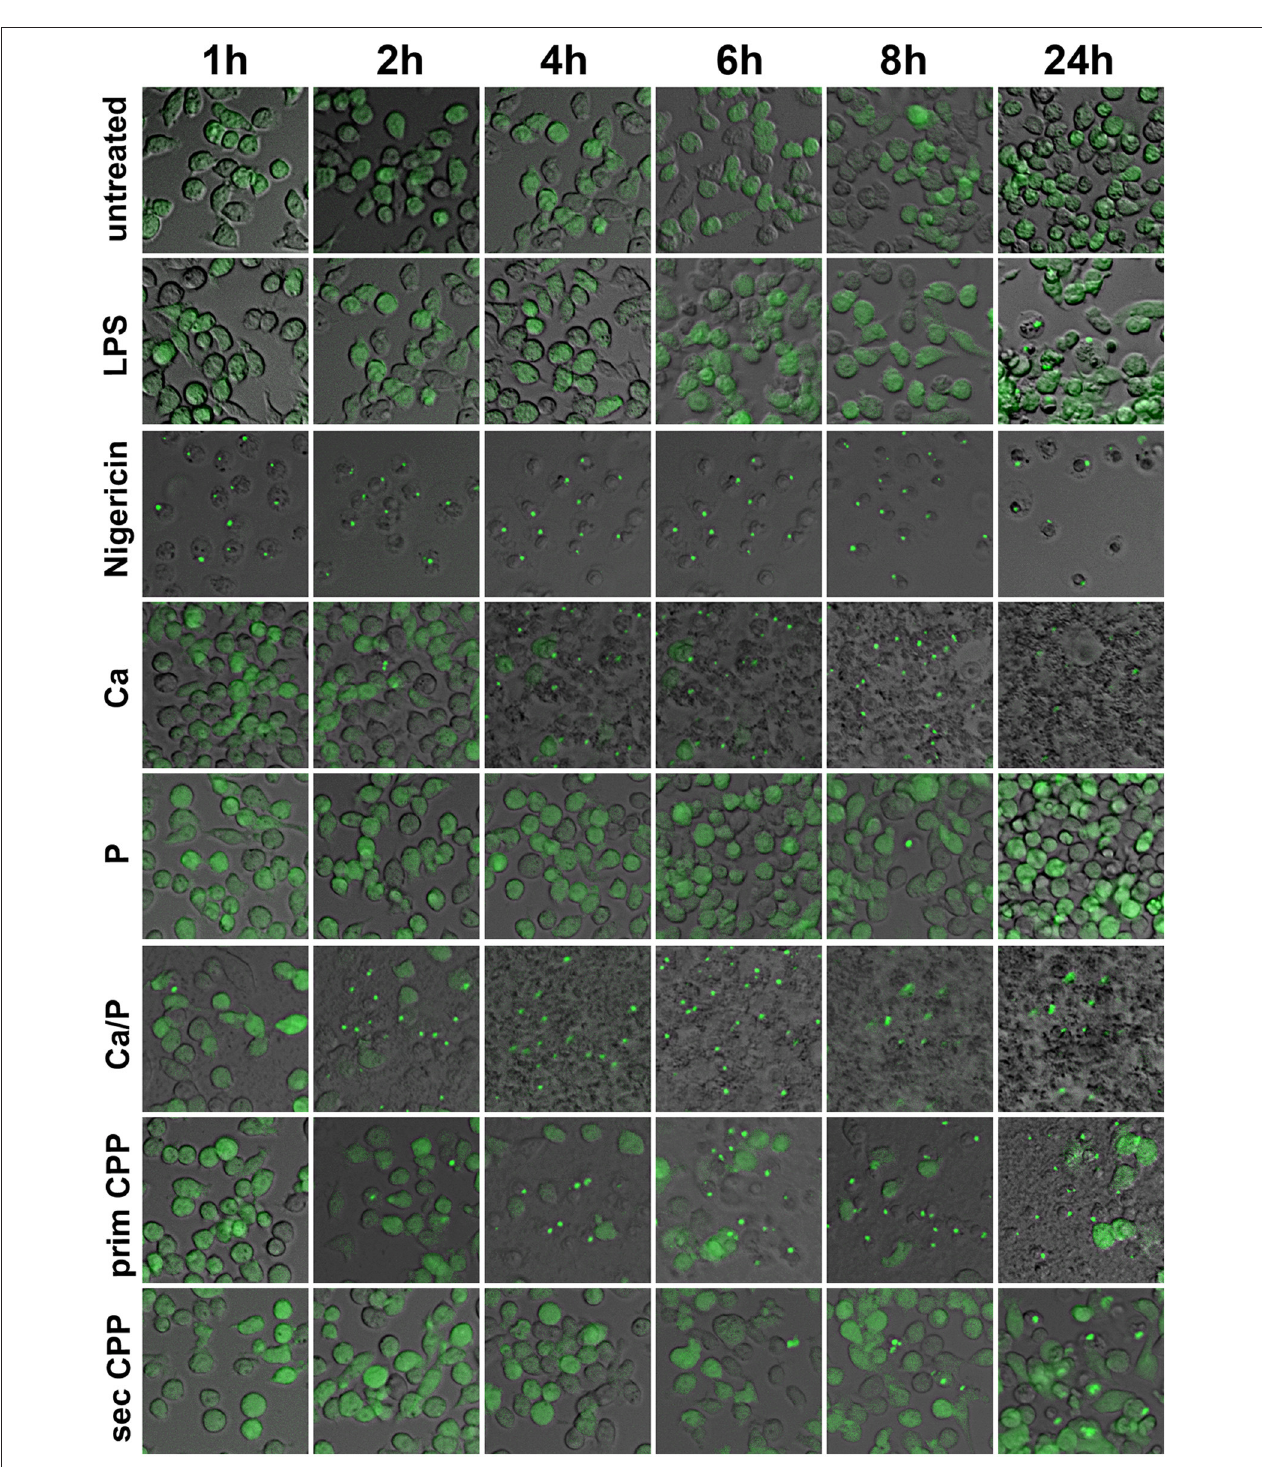
FIGURE 7 | Calcification media induce differential cellular calcium overload and inflammasome activation. Immortalized macrophages expressing the inflammasome adaptor protein labeled apoptosis-associated speck like protein containing a caspase recruitment domain ASC fused to green fluorescent protein, were exposed to buffer control, LPS, nigericin, or to calcification media with elevated calcium or phosphate, individually and in combination, as well as with primary or secondary CPP. Notably, all calcification media contained an identical total calcium dose of 100 µ g, yet differed in the stability of the calcium containing mineral component.